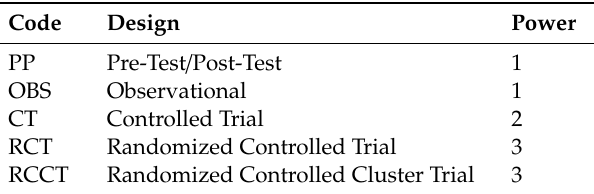
Table 1. Coding table for study designs. The table shows the types of studies examined in the review and the power assigned to them. Code Design Power PP Pre-Test / Post-Test 1 OBS Observational 1 CT Controlled Trial 2 RCT Randomized Controlled Trial 3 RCCT Randomized Controlled Cluster Trial